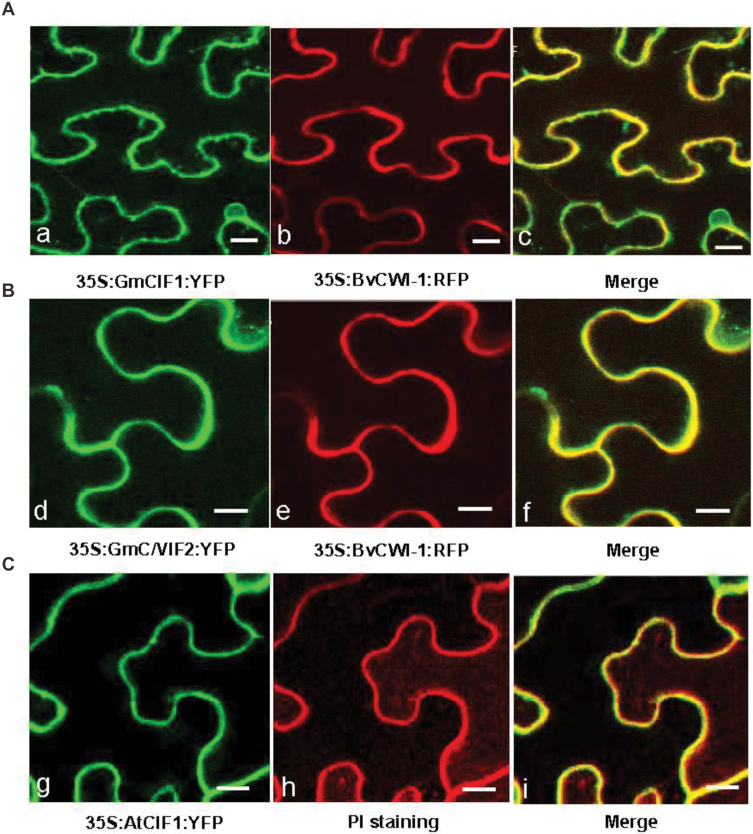
Apoplastic localization of GmCIF1 and GmC/VIF2 in tobacco leaves. Tobacco leaves were co-infiltrated with Agrobacterium culture harboring the constructs of (A) 35S:GmCIF1:YFP and 35S:BvCWI-1:RFP or (B) 35S:GmC/VIF2:YFP and 35S: BvCWI-1:RFP. (C) Apoplastic localization of AtCIF1 and PI (propidium iodide) staining. (a, d) Epidermal cells depicting YFP (green) fluorescence. (b, e) RFP (red) fluorescence in the cell wall. (c, f) Overlap of fluorescent signals (yellow) from YFP and RFP. A sugar beet CWI (BvCWI-1) was used as cell wall-localization marker.